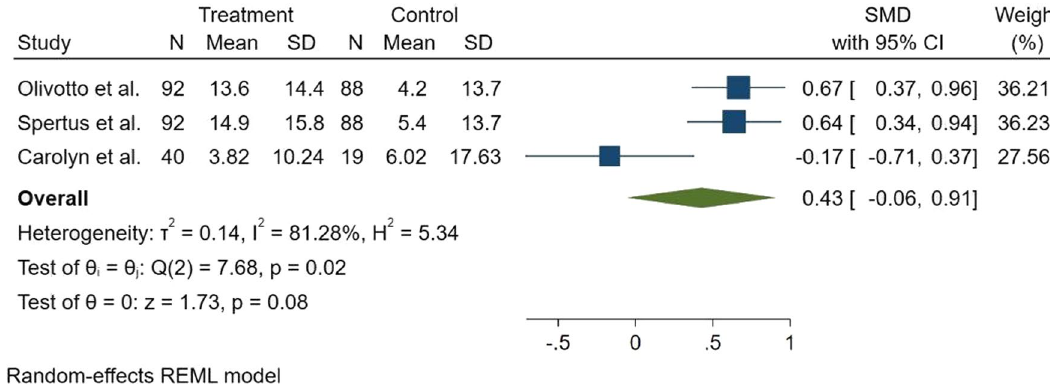
Fig. 2 Forest plot for Kansas City Cardiomyopathy Questionnaire (KCCQ) score